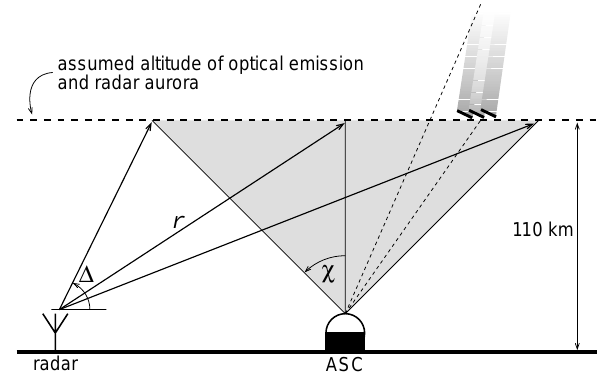
Fig. 3. A schematic diagram showing the method of mapping be- tween radar and ASC observations, where r is radar range, 1 is elevation angle, and χ is zenith angle. In our algorithms, a curved Earth is